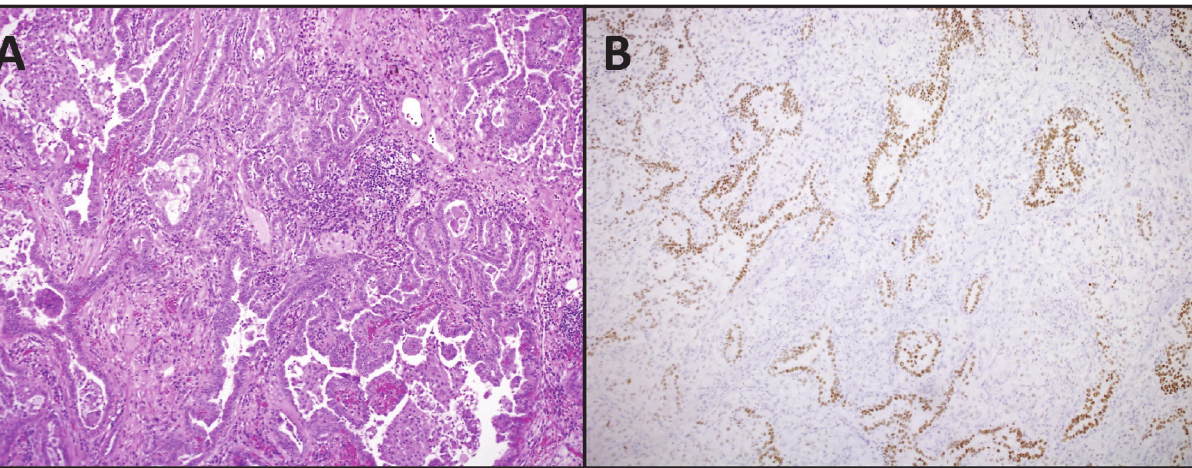
Fig 2. Sections from the tumor of one of the patients with hematoxylin and eosin staining shows infiltrating tumor glands with acinar, lepidic and focal papillary features with surrounding areas of dense fibrosis and scattered chronic inflammation (A). These tumor cells stain positive with TTF-1